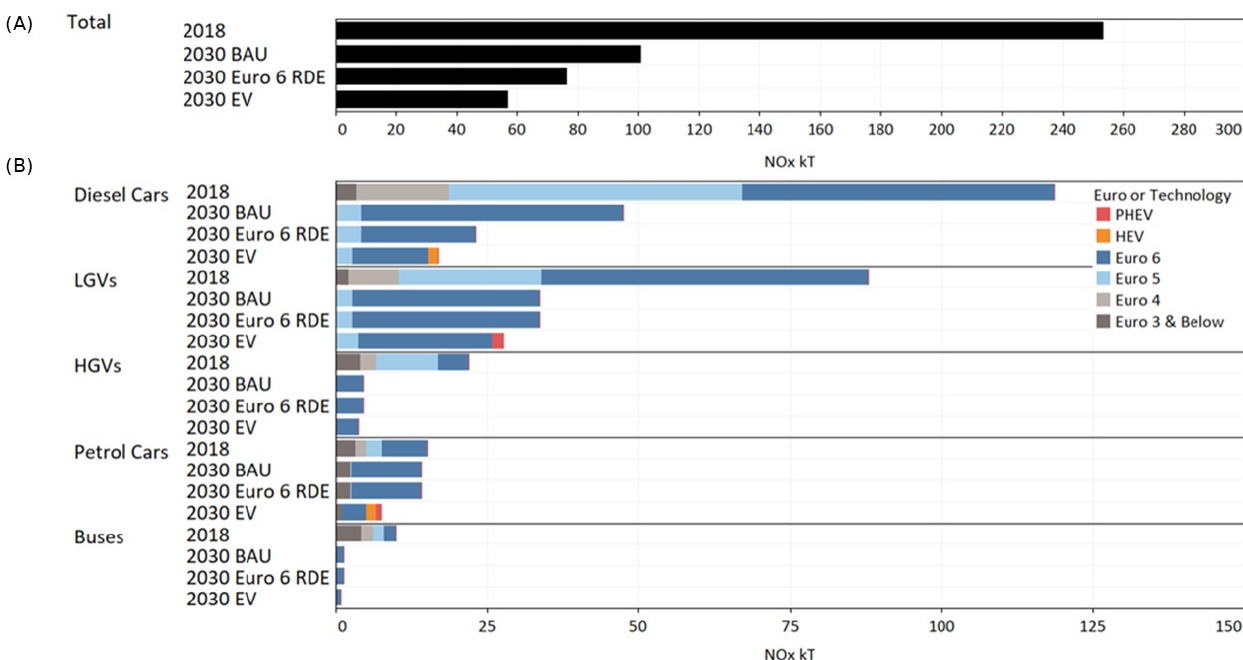
Figure 2. ( A ) Total fleet emissions of NO x for each scenario in 2030. ( B ) NO x emissions given by vehicle type, where colour shows the emissions from each euro standard or fuel type.